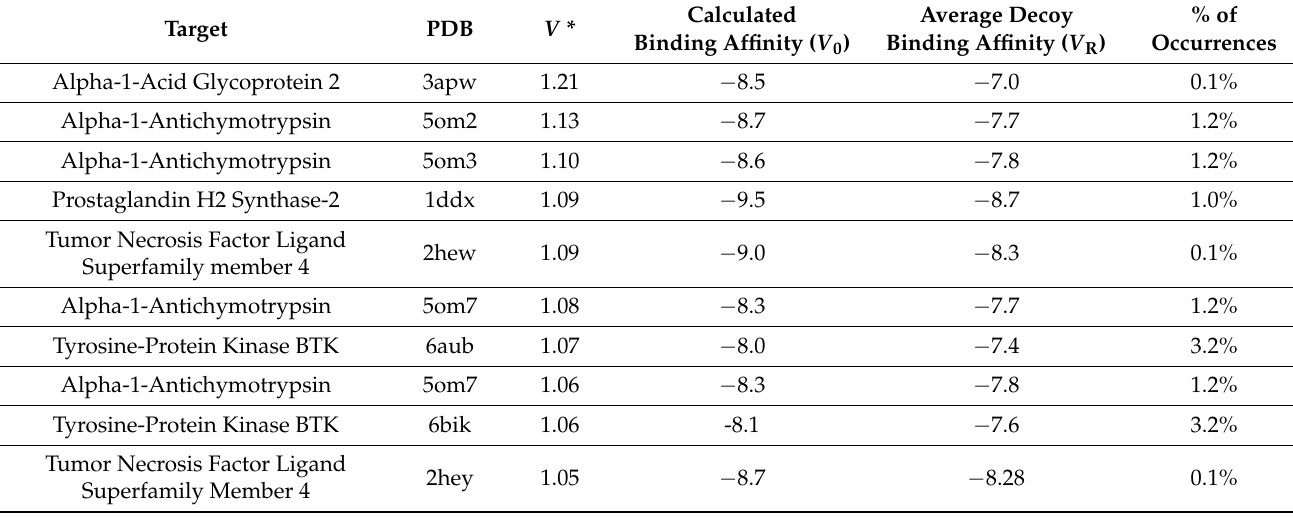
Table 2. IVS target ranking for 2 . The percentage of occurrences is calculated on the number of target structures with a V value above 0.9.